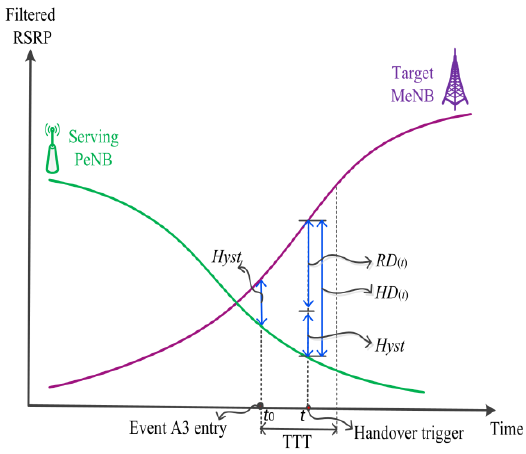
Fig. 6. The handover mechanism for out-pico scenario. As shown in Fig. 6, RD ( t ) indicates the difference in the RSRPs of the UE between the target eNB, M , and serving eNB, P , calculated by Eq. (11). HD ( t ) is defined as the difference between RD ( t ) and Hyst when the UE gets service from the serving PeNB_ P at time t , calculated by Eq. (12).